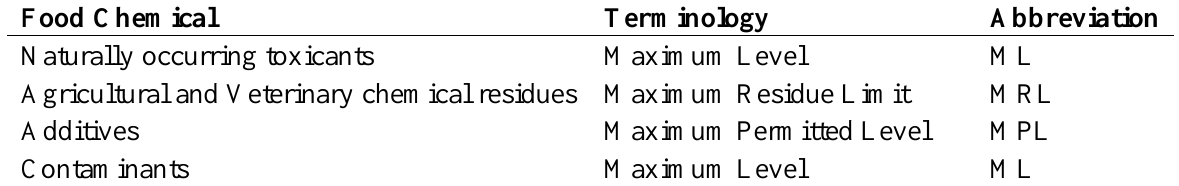
Table 3. Nomenclature used in food regulations to describe maximum levels of food chemicals in foods set in food standards, used for assessing compliance (all expressed per kg